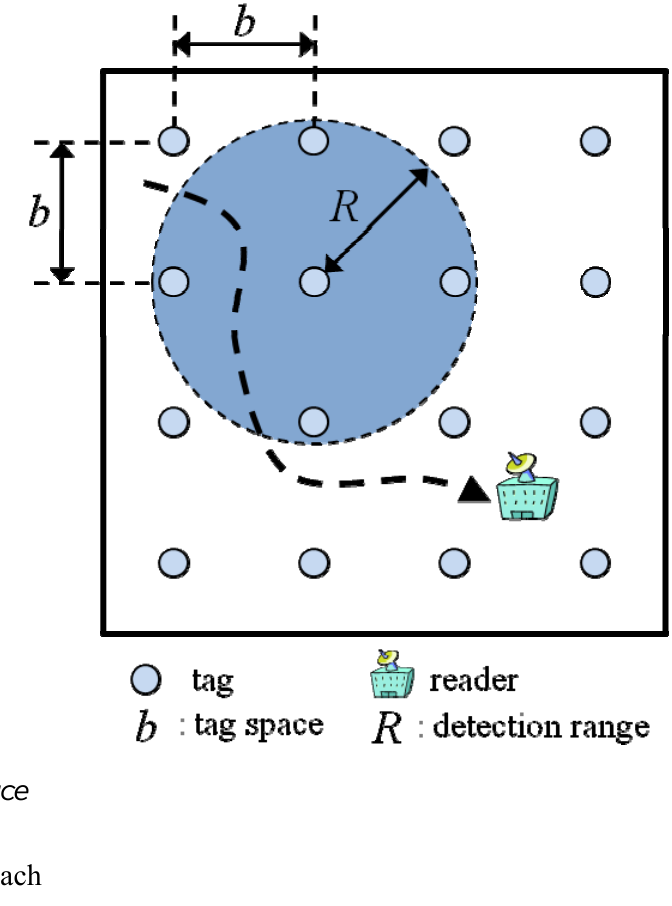
Figure 1. Concept of simulation in a 2-dimensional space.